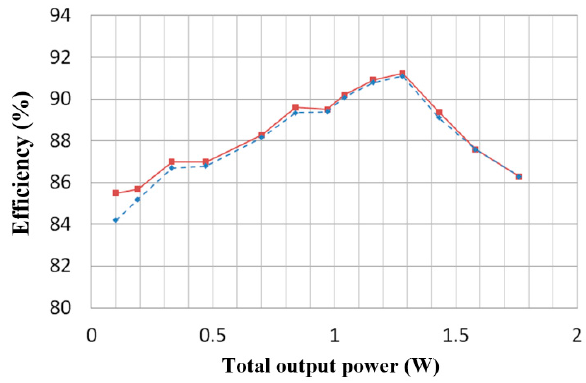
Figure 14. Solid line is the measured efficiency of the proposed EDRC scheme versus total output power. Dashed line is measured e ffi ciency without adopting the NDNS technique. power. Dashed line is measured efficiency without adopting the NDNS technique.